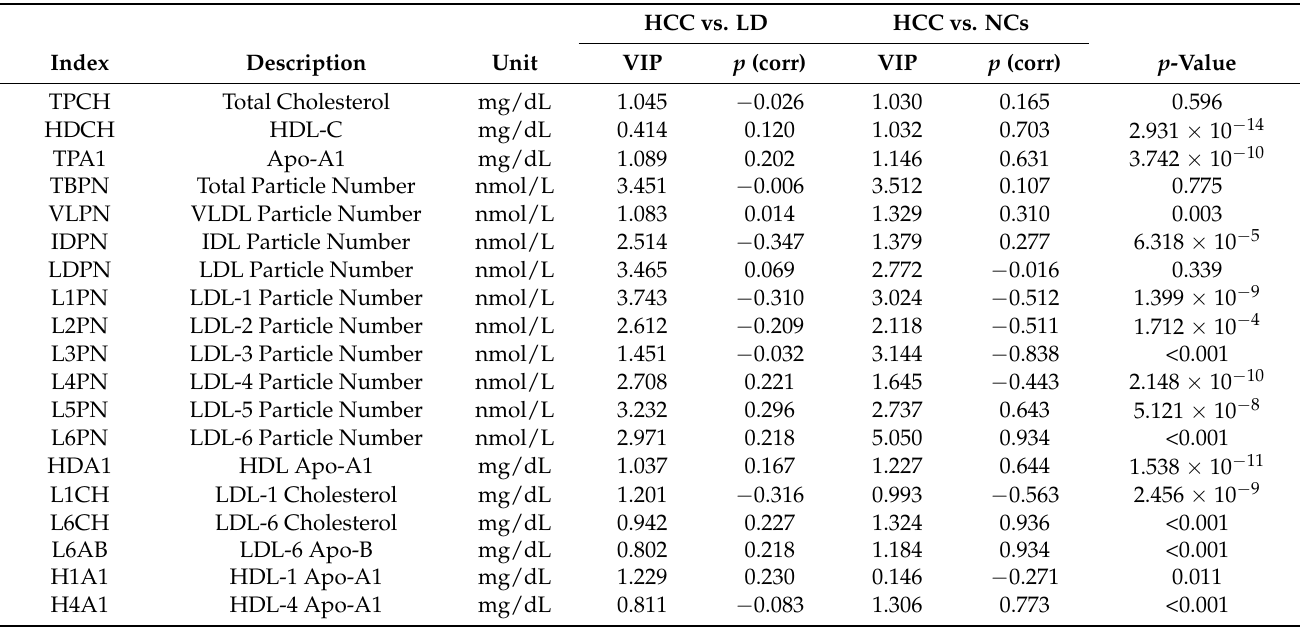
Table 2. Summary of the lipoprotein subfraction statistical data from OPLS-DA analysis from HCC patients, liver disease patients, and normal